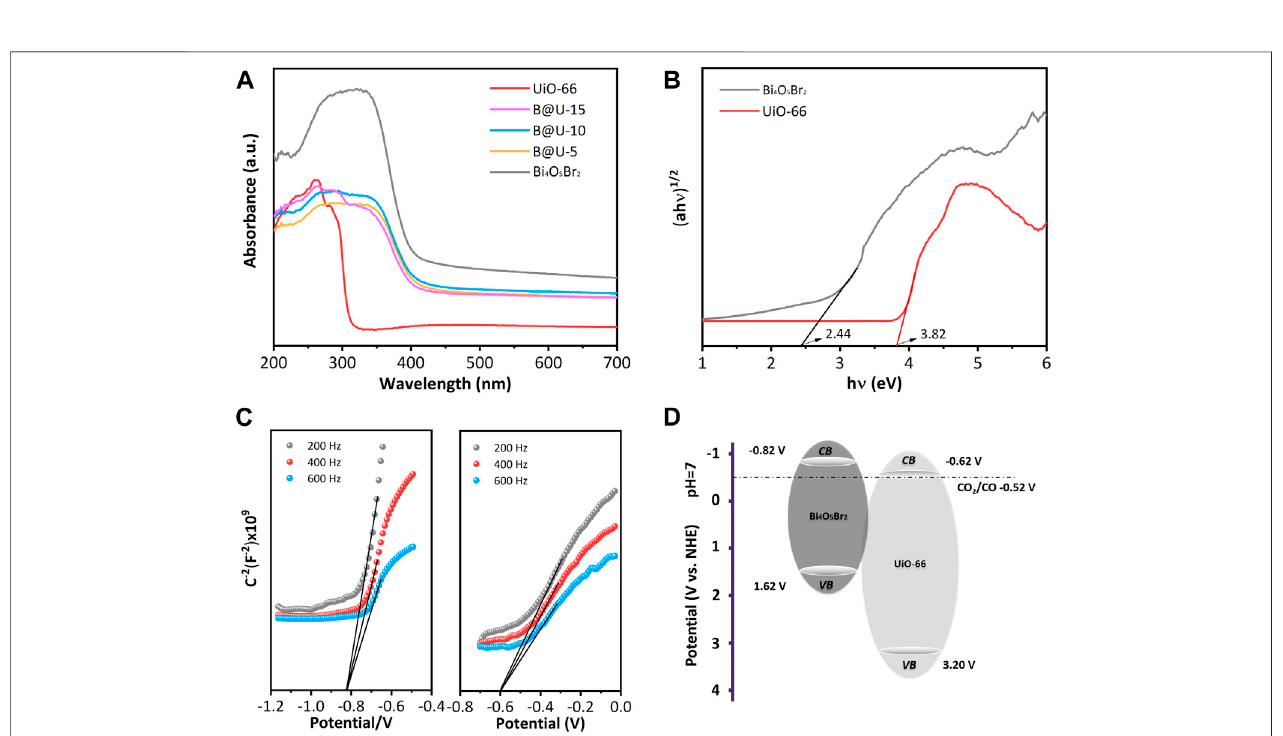
FIGURE 6 | (A) UV – vis spectra, (B) Tauc plots, (C) MS plots, (D) band diagrams of UiO-66, and Bi 4 O 5 Br 2 .